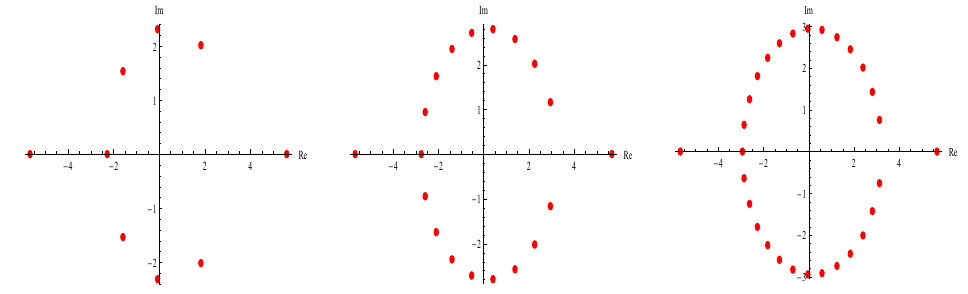
Figure 3. Approximate roots of C B n ,0.5 ( x ,5 ) for n =